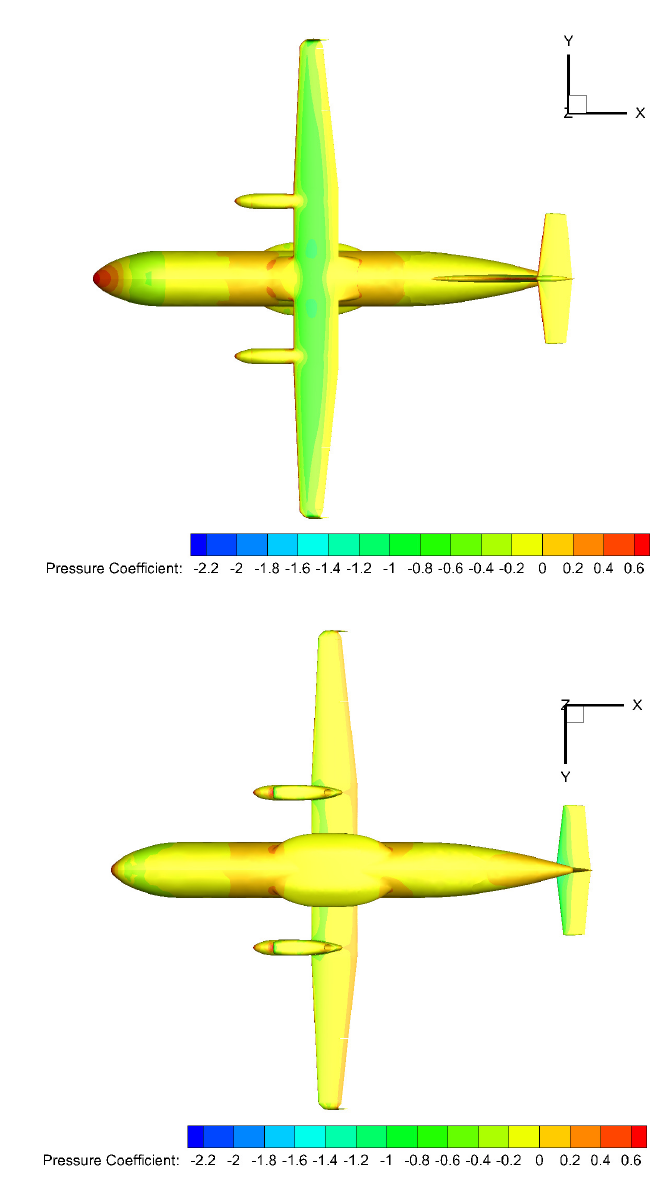
Figure 12. Clean configuration: upper ( top ) and lower ( bottom ) plan views of surface contours for the pressure